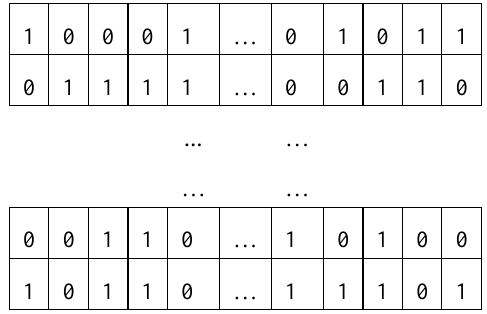
Figure 6. Initial population of N Gen